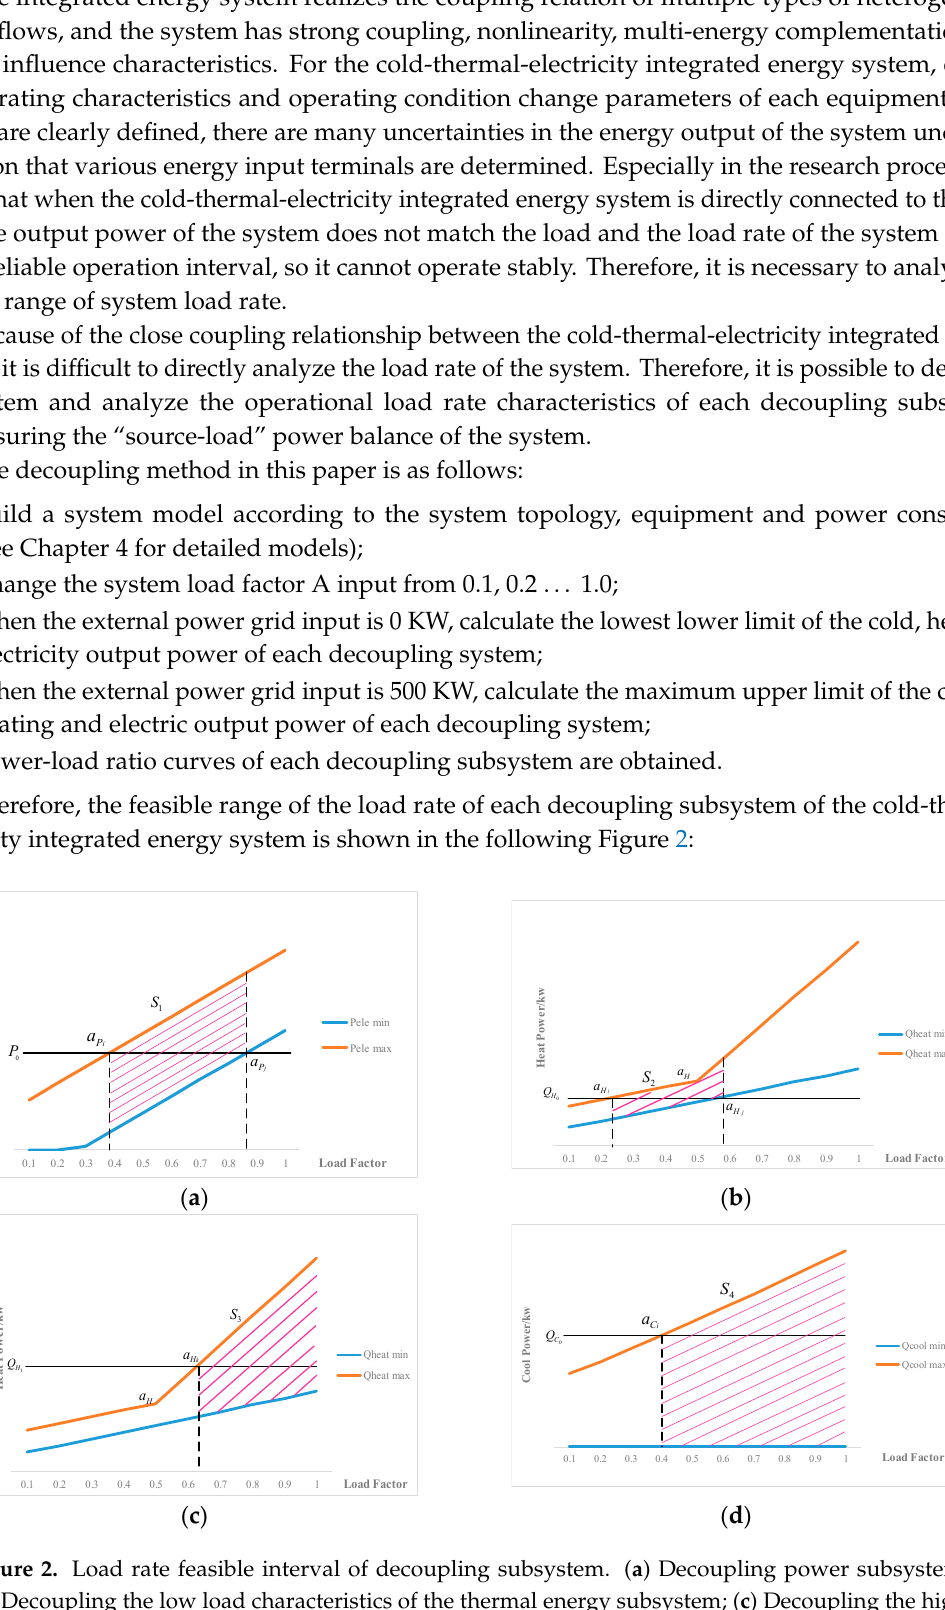
Figure 2. Load rate feasible interval of decoupling subsystem. ( a ) Decoupling power subsystem; ( b ) Decoupling the low load characteristics of the thermal energy subsystem; ( c ) Decoupling the high load characteristics of the thermal energy subsystem; ( d ) Decoupling the cold energy subsystem.